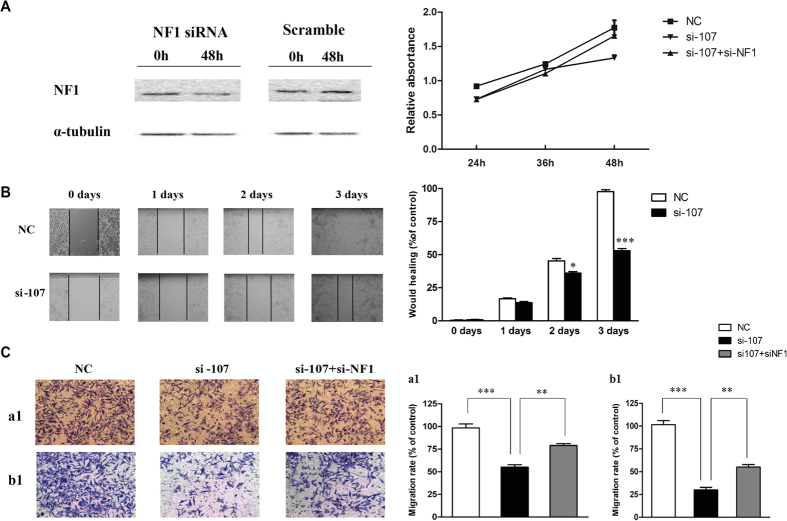
miR-107 knockdown inhibits cell growth, migration and invasion through NF1 upregulation.(A) MGC803 cells were transfected with NC or si-107, or si-107 in combination with si-NF1. At 48 h post-transfection, cells were seeded in 96-well plates and their growth was evaluated by MTT assay at indicated time points (right panel). Left panel, the interference effect of si-NF1 on NF1 expression. (B) MGC803 cells pre-treated with si-107 or NC for 48 h migrated into the wounded area. Left panel shows representative images; right panel shows the quantification of migration rate. (C) Transwell migration (a) and invasion (b) assays were performed in MGC803 cells pre-treated with NC, si-107, or si-107 in combination with si-NF1 for 48 h. Means ± SEM from three independent experiments. *P < 0.05, **P < 0.01, and ***P < 0.001.